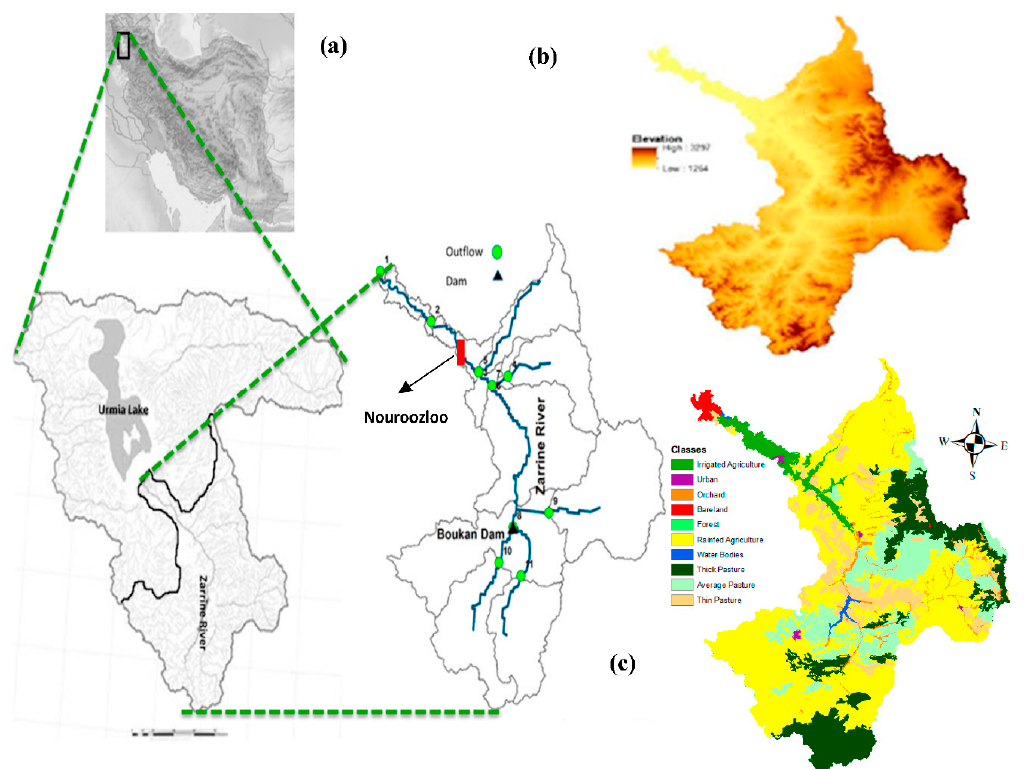
Figure 2. Map of the Lake Urmia basin (Iran) with the ZRB as the major sub-basin and further delineation of the sub-basins with gauge station outlets ( a ) together with DEM ( b ); and land use cover of the ZRB ( c ).